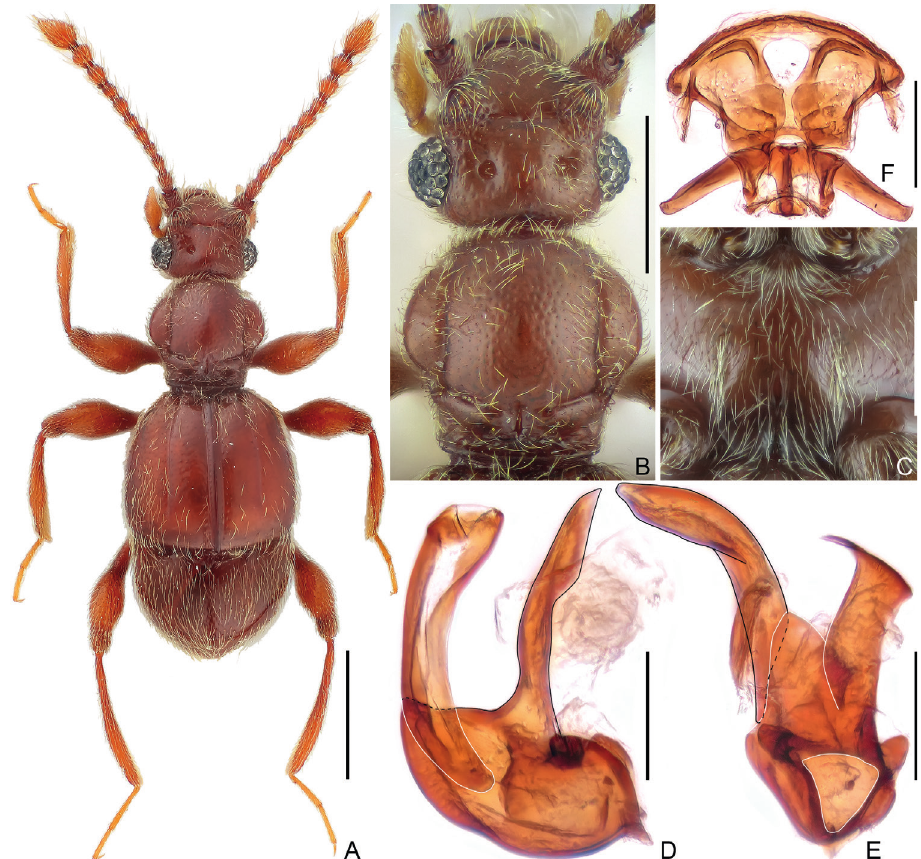
Figure 1. Morphological characters of Trisiniotus taoismus sp. nov. A dorsal habitus B head dorsum and pronotum C central part of metaventrite D, E aedeagus, lateral ( D ) and ventral ( E ) F female genitalia. Scale bars: 0.5 mm ( A ); 0.3 mm ( B ); 0.2 mm ( D–F